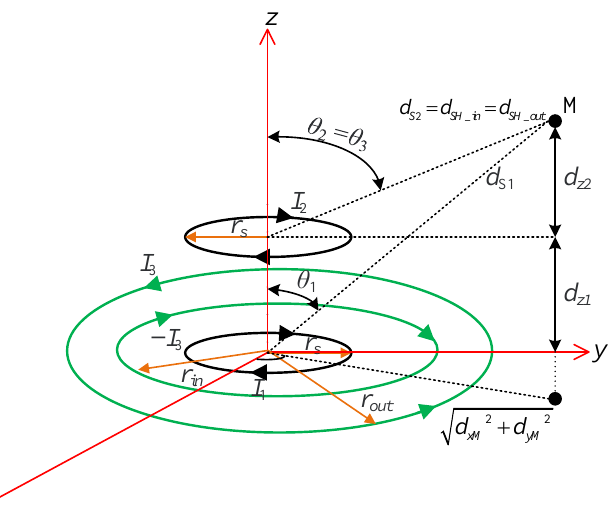
Figure 3. Geometric coil array of transmitting, receiving, and shielding coils. where d S 2 is the distance from the receiving coil to point M; d SH_in and d SH_out are, respectively, the distance from the internal and external shielding coils to point M. The total magnetic flux density B M at point M of the space is calculated by applying superposition as: